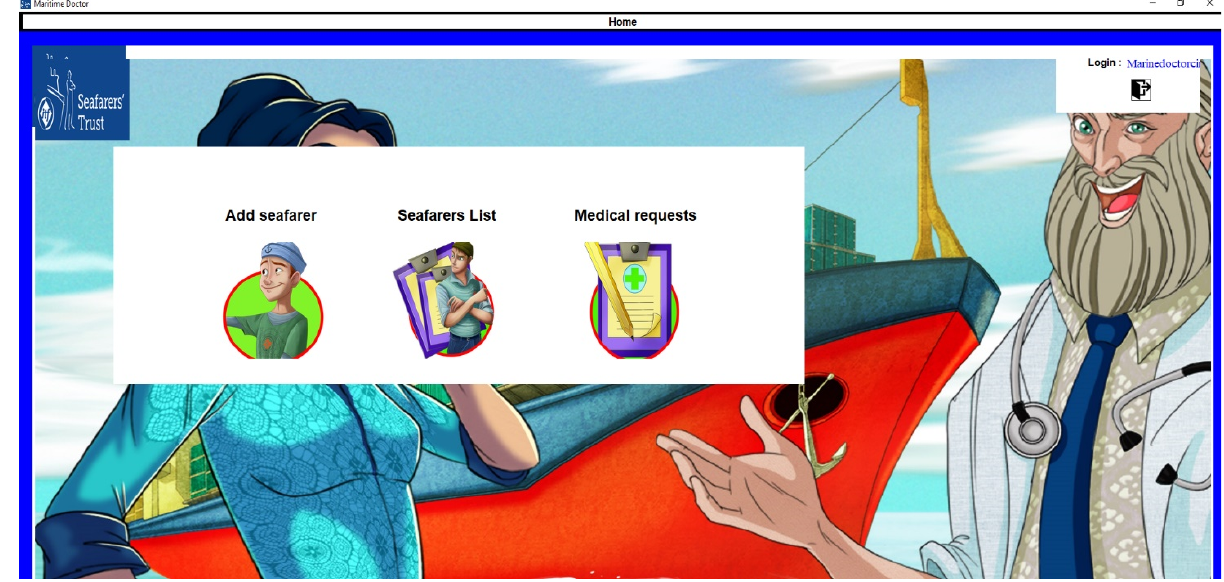
Figure 2. Application home page.